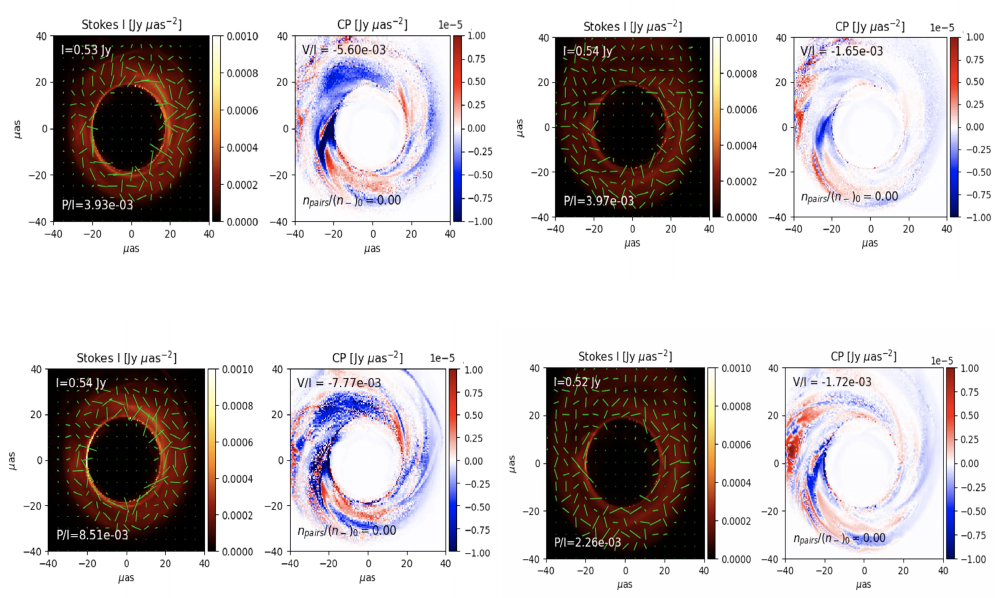
Figure 7. Synthetic intensity with the electric vector polarization angle (EVPA) and circular polar- ization maps for models that include positron effects and piecewise modeling. For the a = − 0.5 SANE at 230 GHz and at T = 25,000 M : ( Top Left ) R-Beta with a β e 0 = 0.01 jet model; ( Top Right ) R-Beta with a β e 0 = 0.01 jet; ( Bottom Left ) Critical Beta Model; ( Bottom Right ) Critical Beta with a β e 0 = 0.01 jet. For each case, the intensity is overplotted with the electric vector polarization angle on the left panel, and the circular polarization degree is mapped on the right